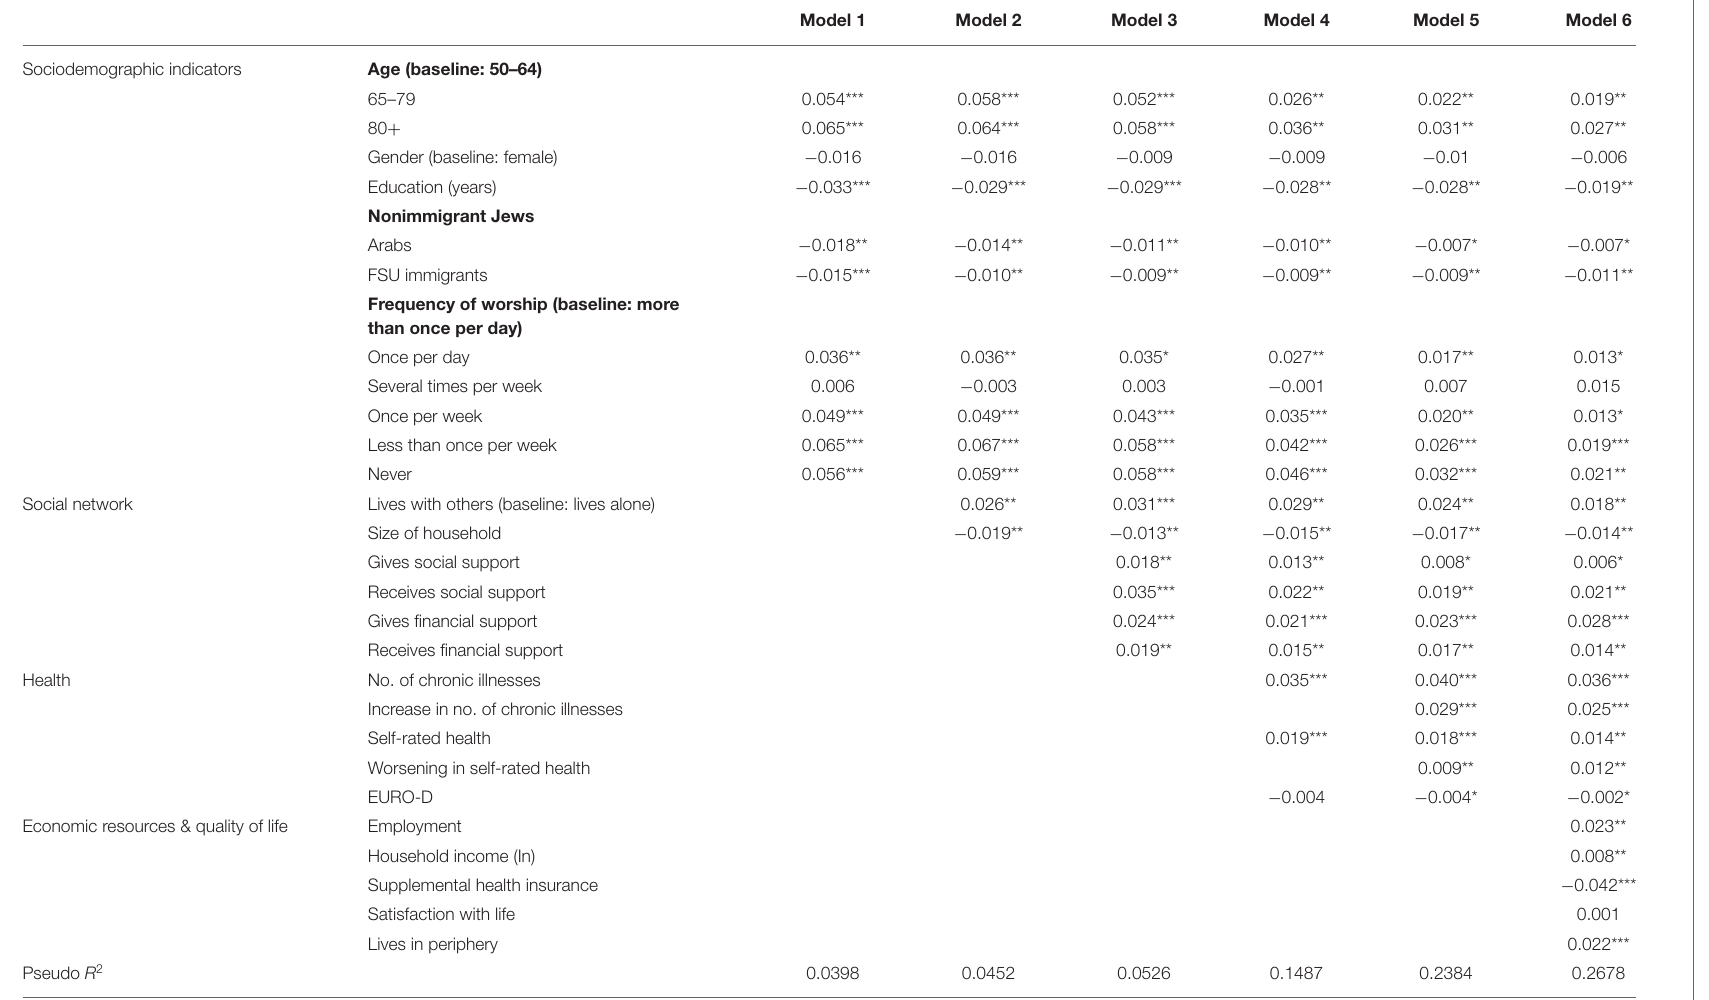
TABLE 4 | Probability models for out-of-pocket expenditure on healthcare services among persons aged 50 + at investigation time 1, panel (marginal